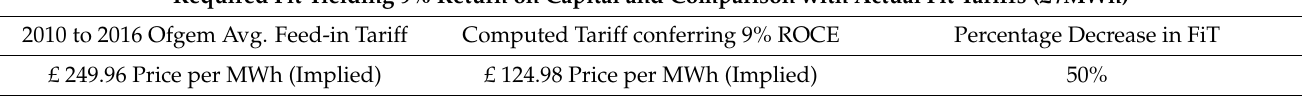
Table 7. Model results of implied FiT for 9% ROCE.